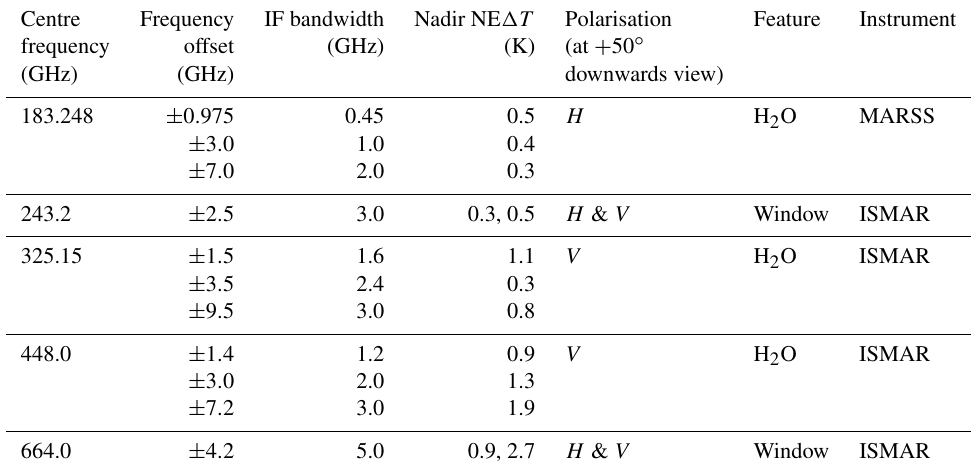
Table 1. ISMAR and MARSS channels with centre frequencies of 183GHz and higher. The column labelled NE (cid:49)T gives the channel noise-equivalent (cid:49)T , i.e. the brightness temperature difference that produces a change in signal equal to the radiometer noise level. Centre Frequency IF bandwidth Nadir NE (cid:49)T Polarisation Feature Instrument frequency offset (GHz) (K) (at + 50 ◦ (GHz) (GHz) downwards view)